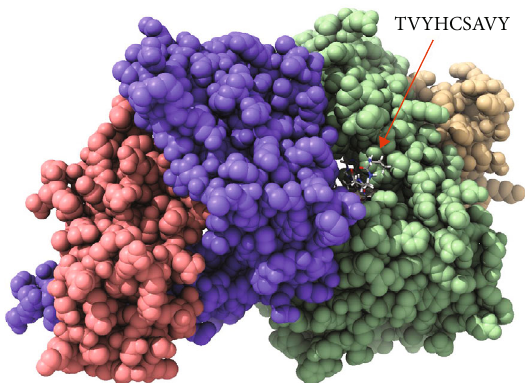
Figure 7: Molecular docking of TVYHCSAVY peptide of Nipah virus docked in HLA-A ∗ 02:01 and visualized by UCSF Chimera X version